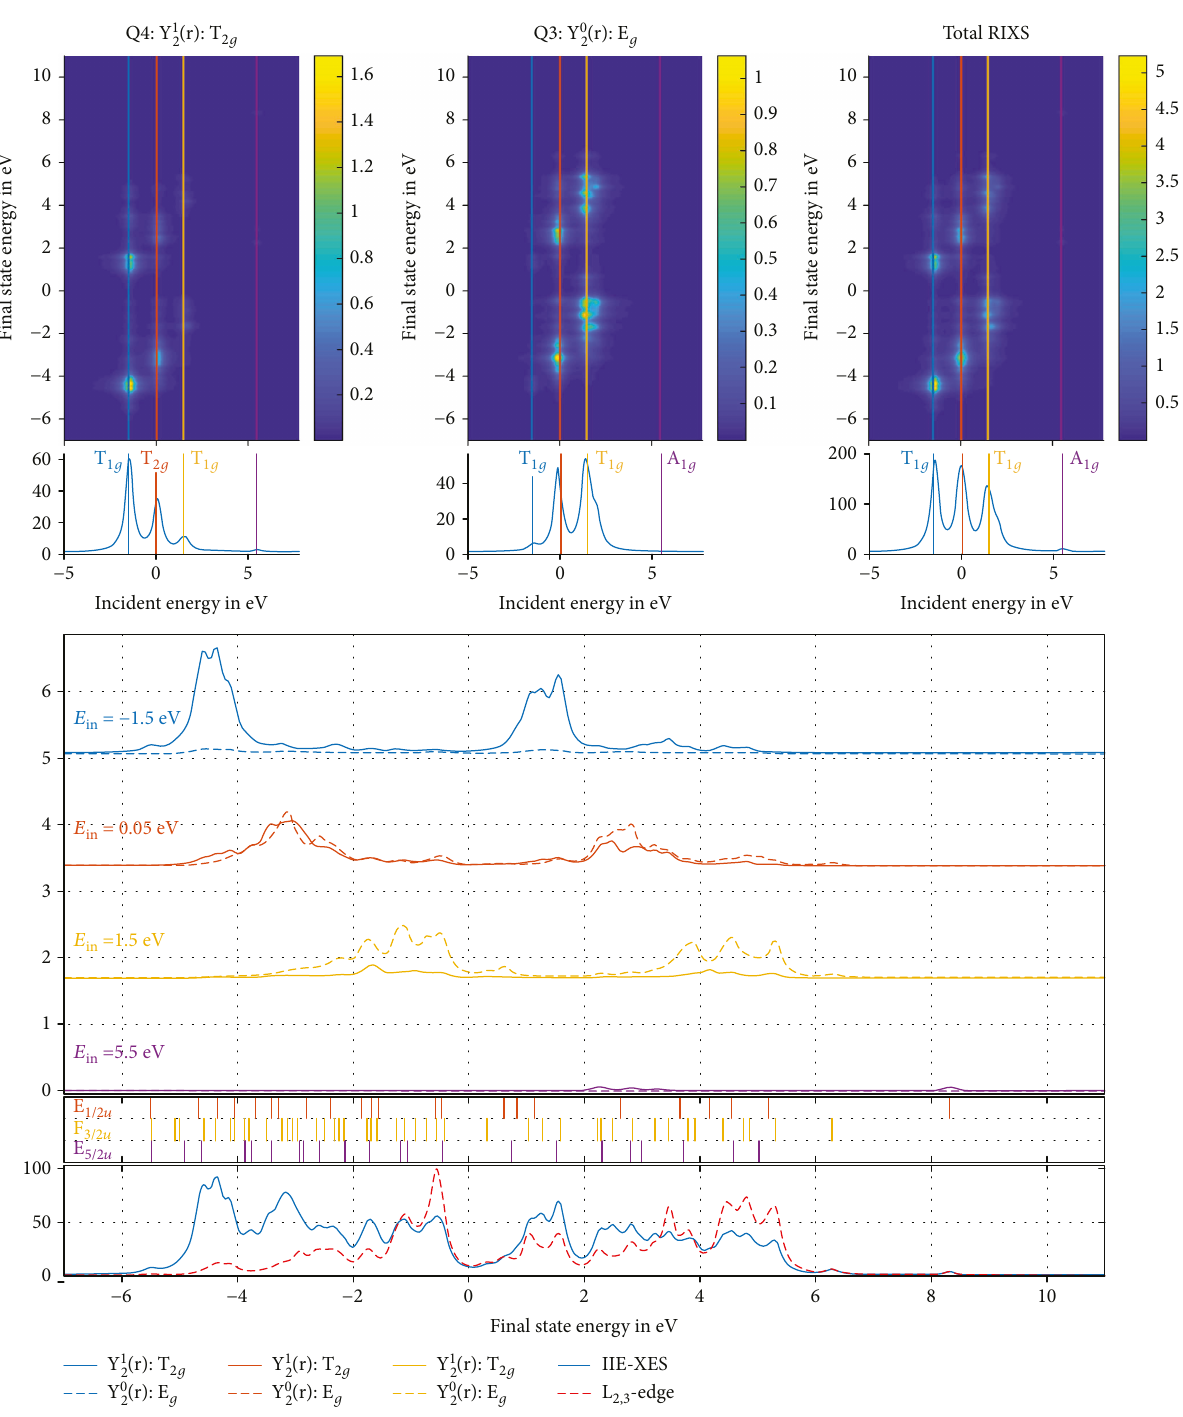
Figure 23: Calculated 1s2p RIXS spectrum for Ti 3+ ( 3d 1 ) for 10D q = 1 5 eV shown together with some selected CIE slices. The stick spectrum at the bottom illustrates the distribution of the three fi nal state terms E